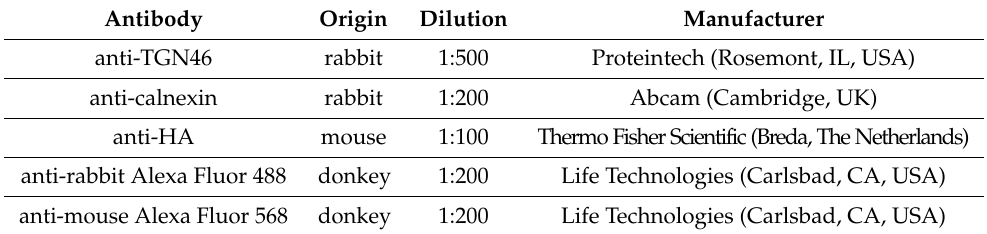
Table 2. Antibodies used in immunofluorescence staining experiments.